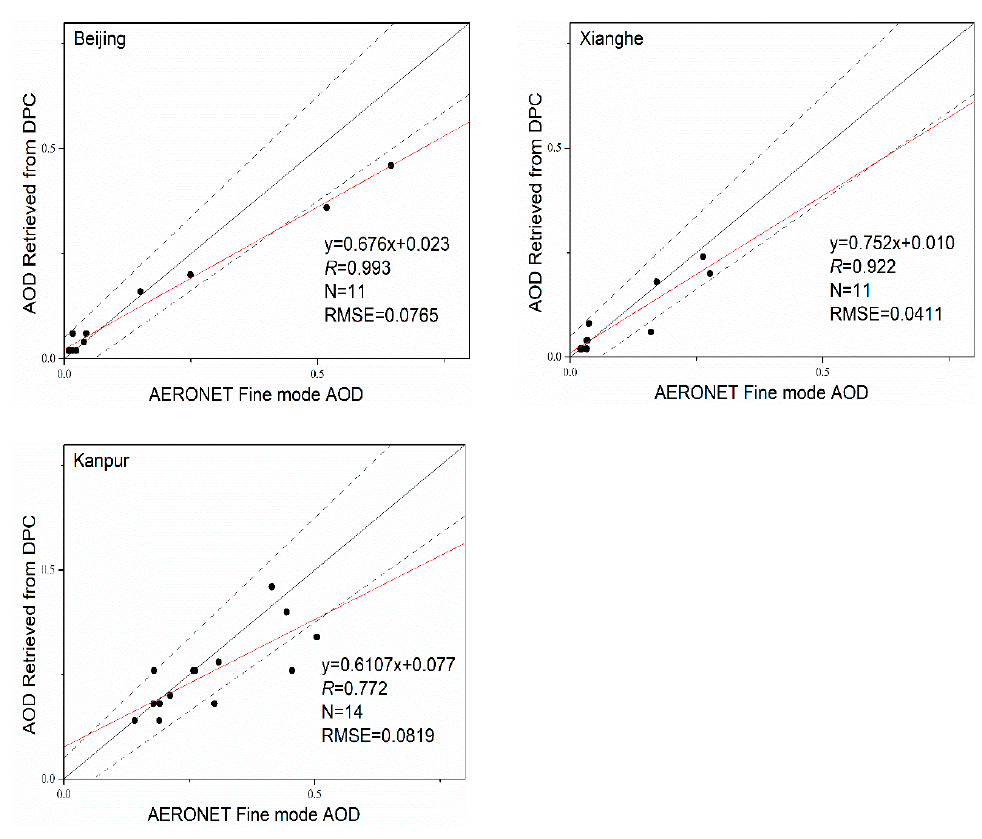
Figure 2. Correlation of the AOD derived from DPC and AERONET AOD measurements and fine-mode AOD retrievals over Beijing, Xianghe and Kanpur. The dash lines correspond to ± 0.05 ± 0.15 τ AERONET error where τ AERONET is the simultaneous AERONET AOD measurements. The black and red solid line represent the one-to-one line and the fitting line, respectively.